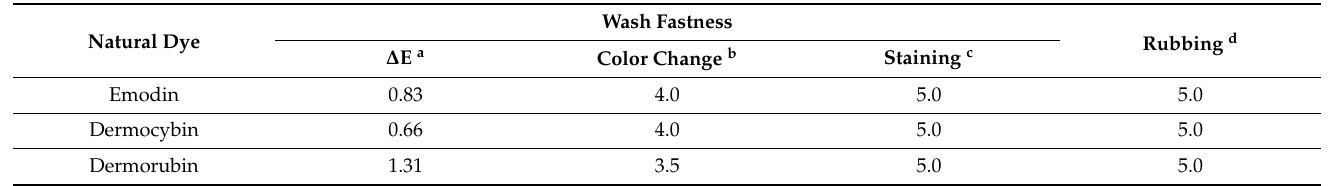
Table 2. Wash fastness ( ∆ E, color change and staining) and rubbing fastness assessment results obtained from polyester fabric dyed with blood-red webcap dyes in Sc-CO 2